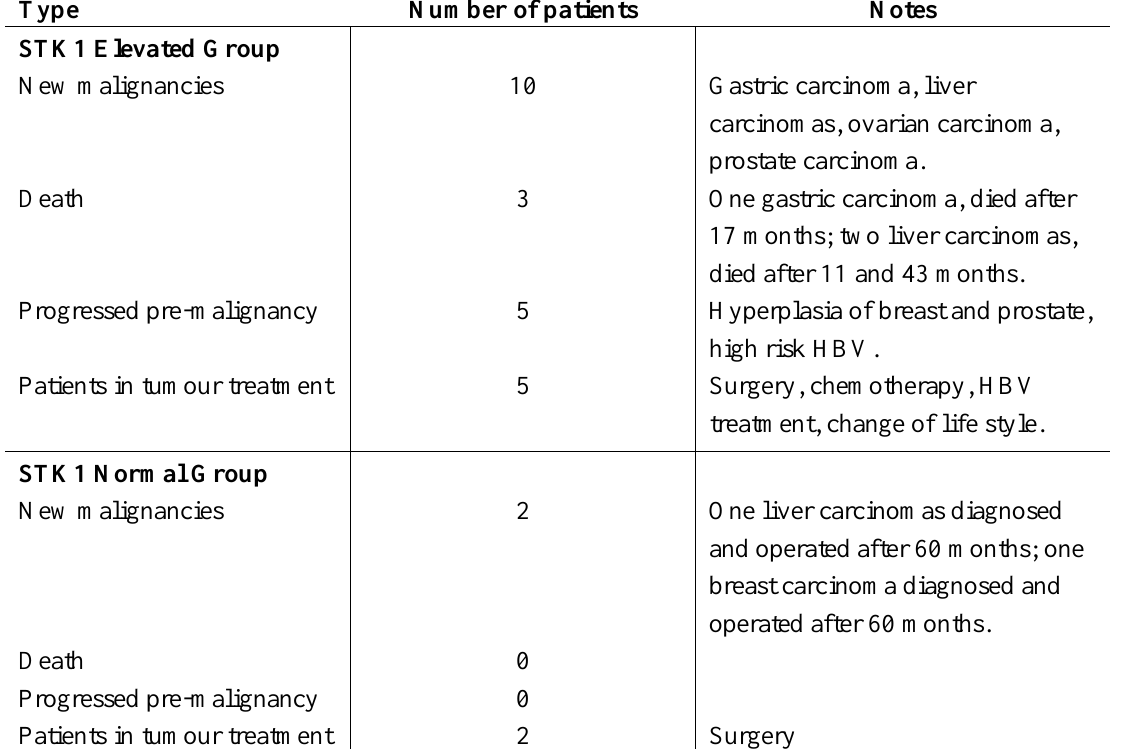
Table 7. Follow-up of the STK1 elevated group (170/702) and the STK1 normal group (6,354/26,484). The follow-up time was 5 to 72